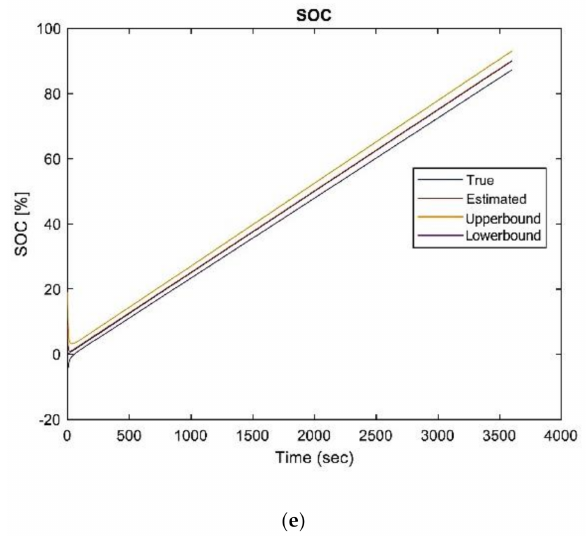
Figure 7. Voltage-measured observer estimation values using wrong initial values; ( a ) terminal